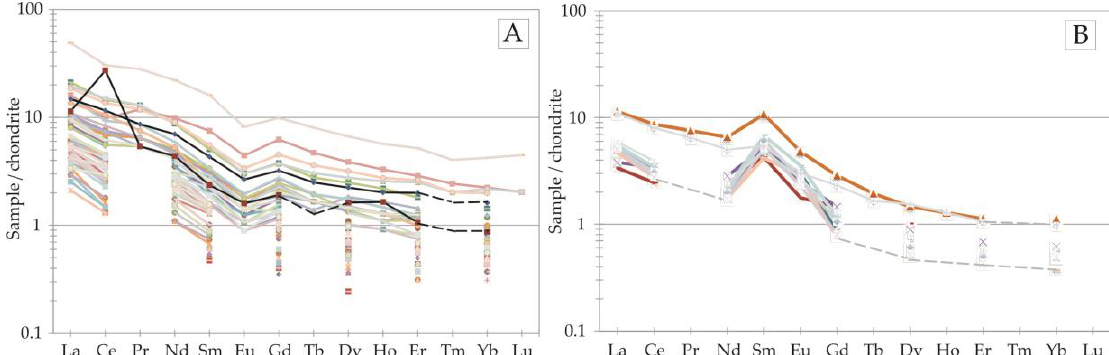
Figure 12. ( A , B ) Comparison of REE content plots in the bulk-rock analyses of Zn-Pb sulfide ores and red galmans (Zn oxide ores, black line) from the MVT deposits in Poland: ( A ) Normalized to chondrite (according to [70]), note negative Eu ( A ) and positive Sm ( B ) anomalies. Positive Sm anomalies are due to high barite content in Zn-Pb ore.